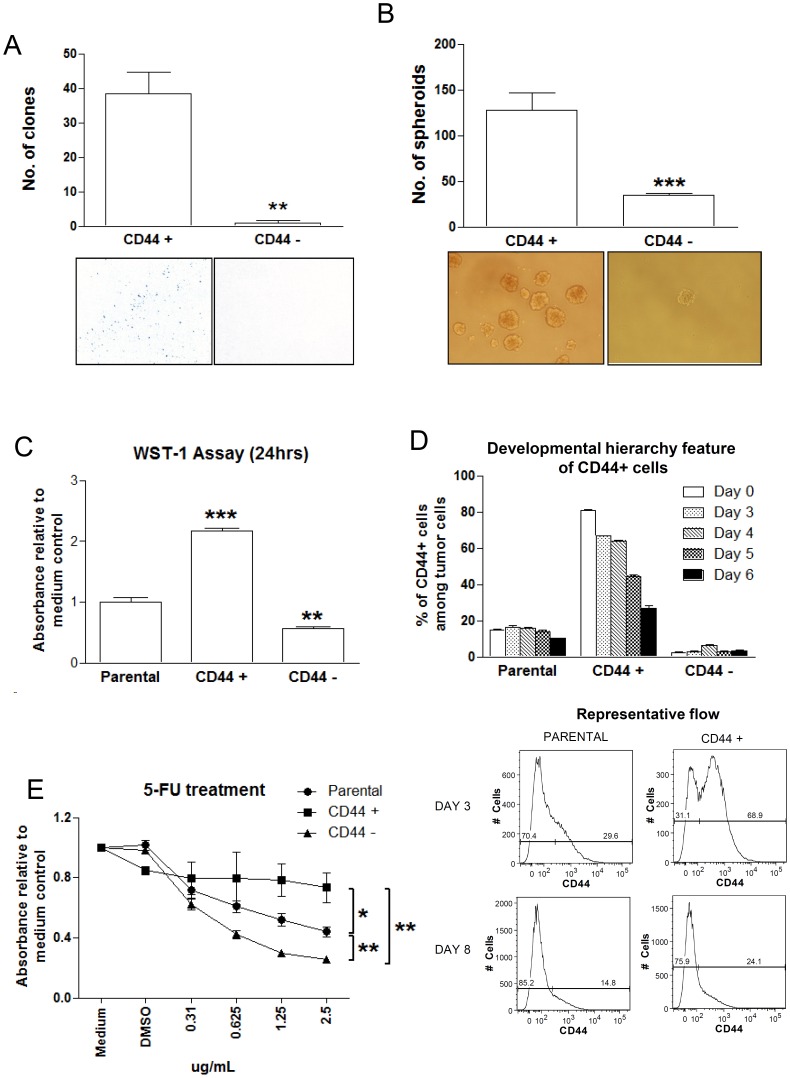
CD44+ cells with stem cell-like properties in EBV-positive NPC.CD44+ cell fraction exhibited a significantly higher (A) clone formation efficiency and (B) sphere-forming efficiency when compared to CD44− cell fraction. In addition, (C) CD44+ cells exhibited significantly higher proliferation rate than CD44− cells. (D) Developmental hierarchy feature of CD44+ cells. Percentage of CD44+ cells were continually reduced in the isolated CD44+ cell fraction over time. (E) CD44+ cells exhibited higher resistance to 5-FU treatment when compared to the CD44− and parental C666-1 cells. All graphs denoting mean ± SE (n≥3) with statistical significance calculated by t-test (*P<0.05, **P<0.01, ***P<0.001).